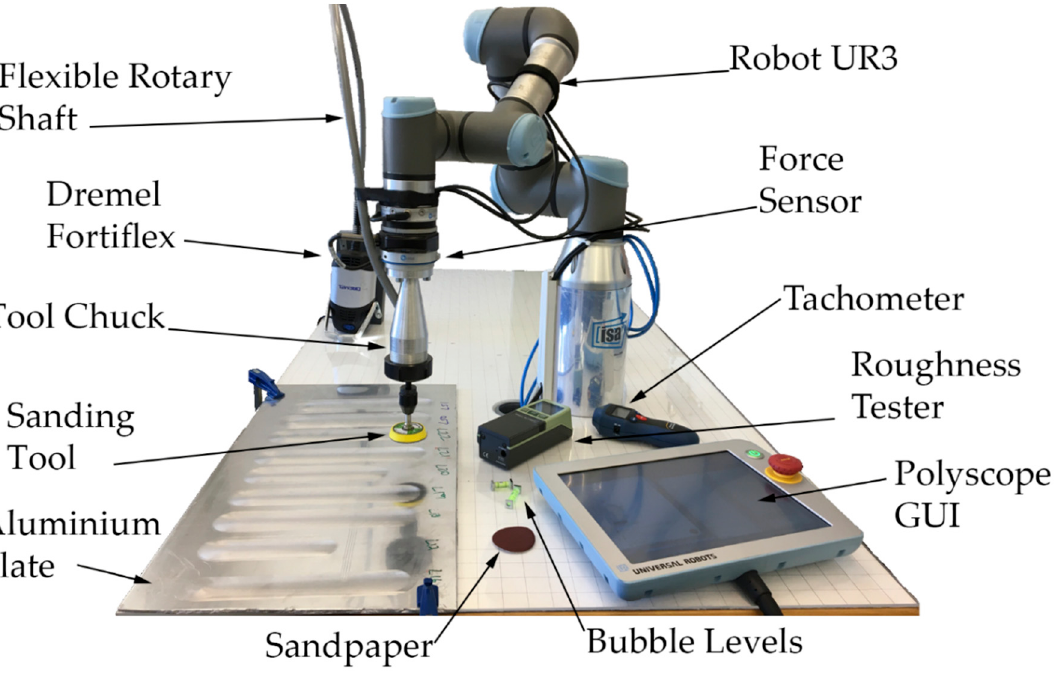
Figure 1. Experimental setup.